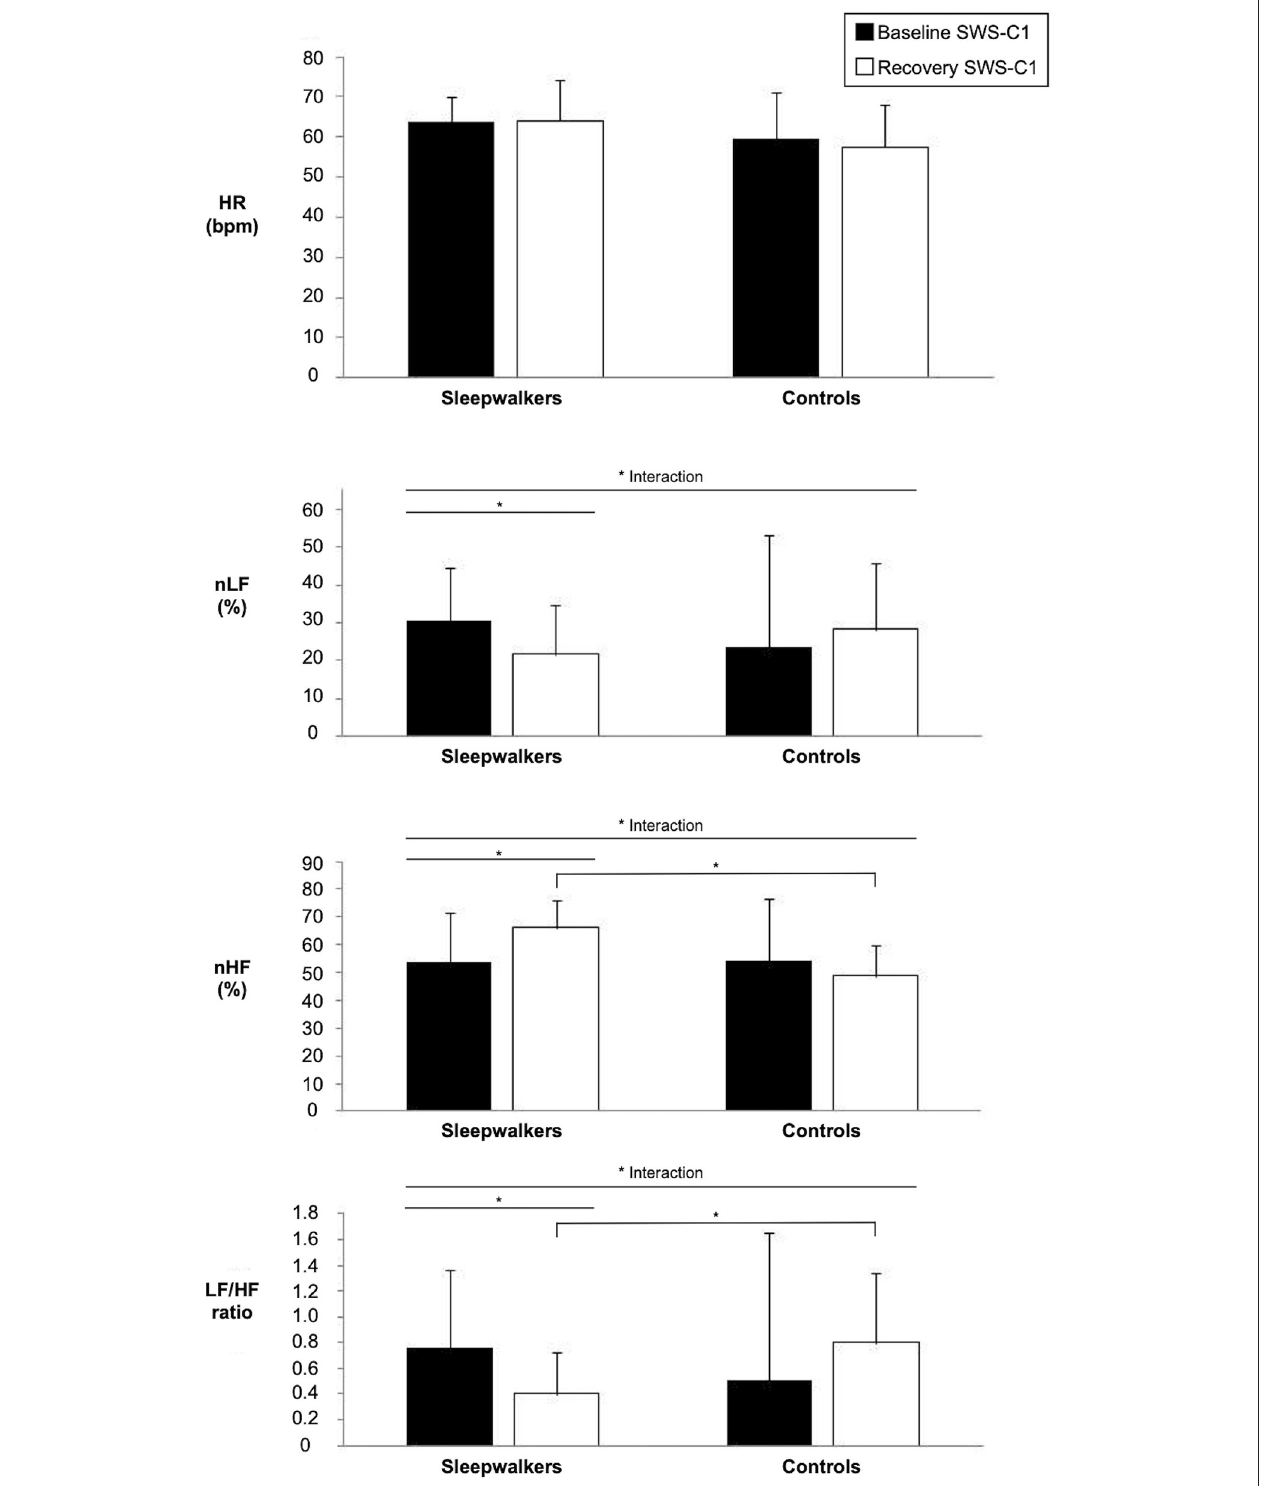
FIGURE 1 | Significant interactions of HRV variables during slow-wave sleep in the first sleep cycle of sleepwalkers and controls for baseline and recovery sleep. Bars represents means and standard deviations. (*) show significant findings. HRV, heart rate variability; HR, heart rate; nLF, low frequency in normalized units as a percentage of total power; nHF, high frequency in normalized units as a percentage of total power SWS-C1, slow-wave sleep first cycle.